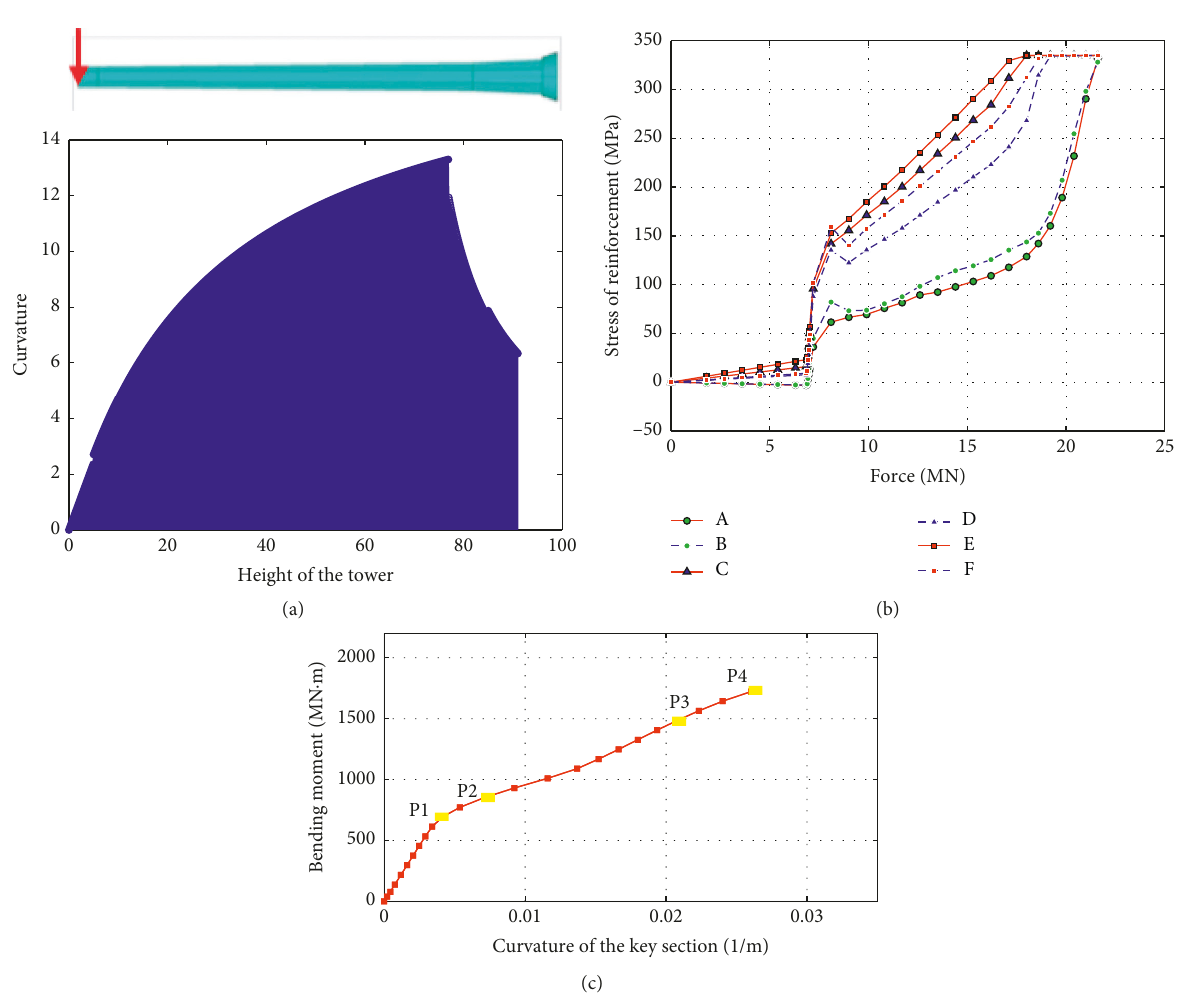
Figure 14: Determination of the LS for the key section. (a) Curvature of the main tower. (b) Steel stress in the key section. (c) M − ϕ curves of the key